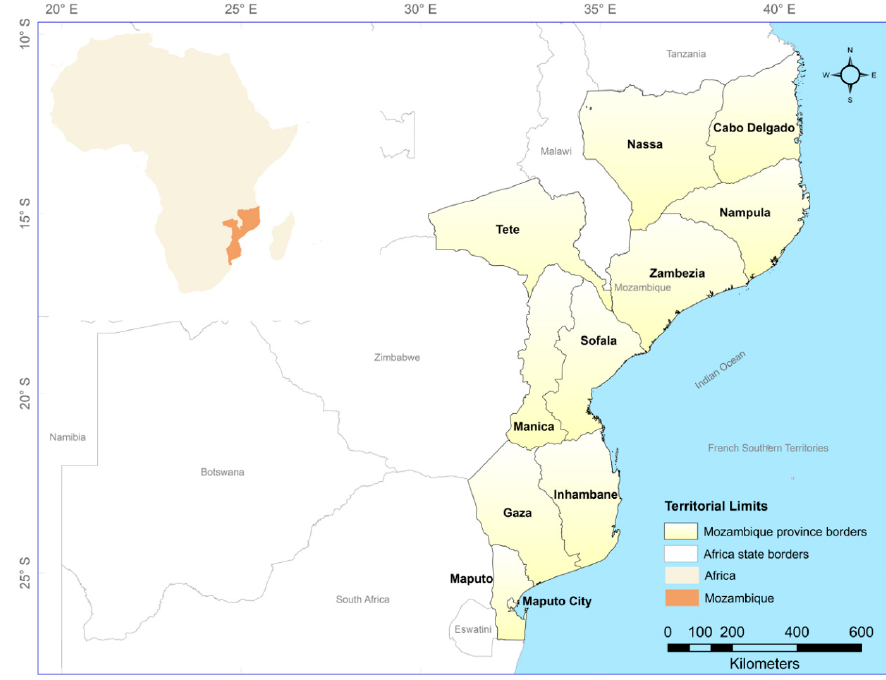
Figure 3. The geographical and spatial position of the study